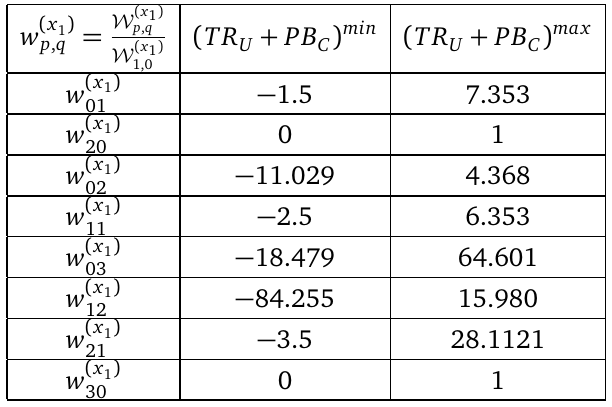
Table 3: A list of bounds obtained using our results TR sation M 2 =